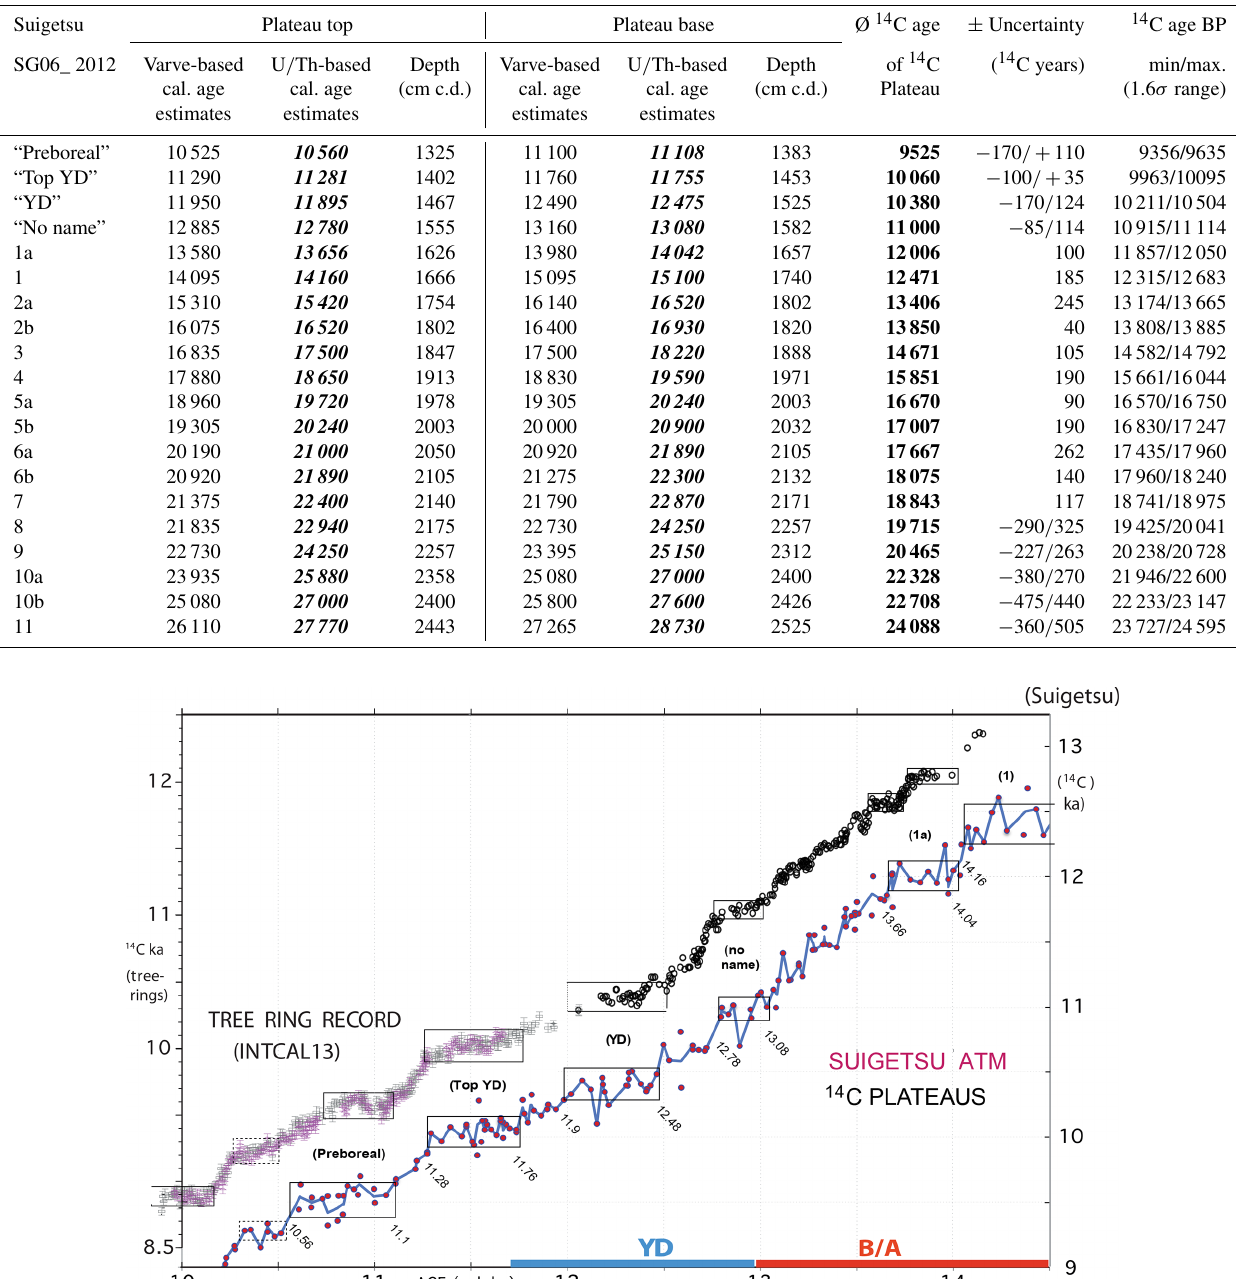
Table 1. Summary of varve- and U / Th model-based age estimates (in calka) (Schlolaut et al., 2018; Bronk Ramsey et al., 2012) for ∼ 30 plateau (pl.) boundaries in the atmospheric 14 C record identified in Lake Suigetsu Core SG06 2012 (composite depth, c.d.) by means of visual inspection over the interval 10.5–27calka (modified from the Supplement to Sarnthein et al., 2015). On the right-hand side, three columns give the average (Ø) and uncertainty range of 14 C ages for each 14 C plateau. YD stands for the Younger Dryas period. Bold and bold-italic fonts mark ages henceforth preferred in this paper; see Sect. 2.2. for more details.